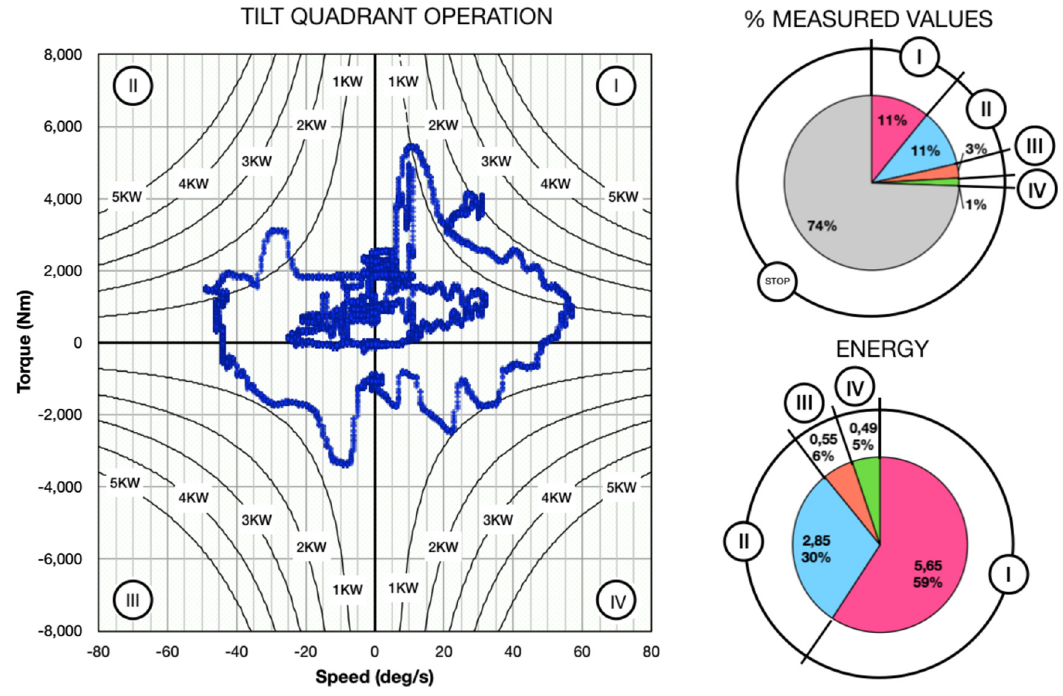
Figure 16. Quadrant operation of the tilt actuator.